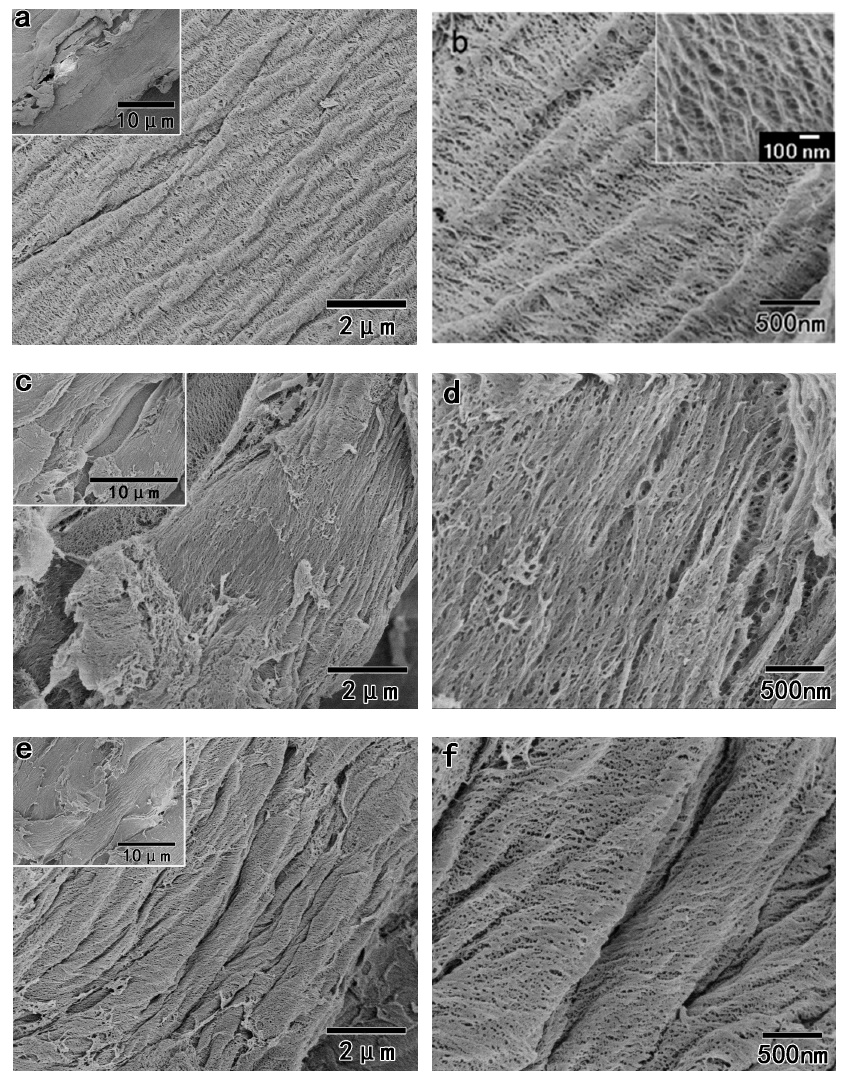
Figure 6. FE-SEM images of the purified pulps: ( a , b ) S 5k1 ; ( c , d ) S 1a4 ; and ( e , f ) S 2a3 .